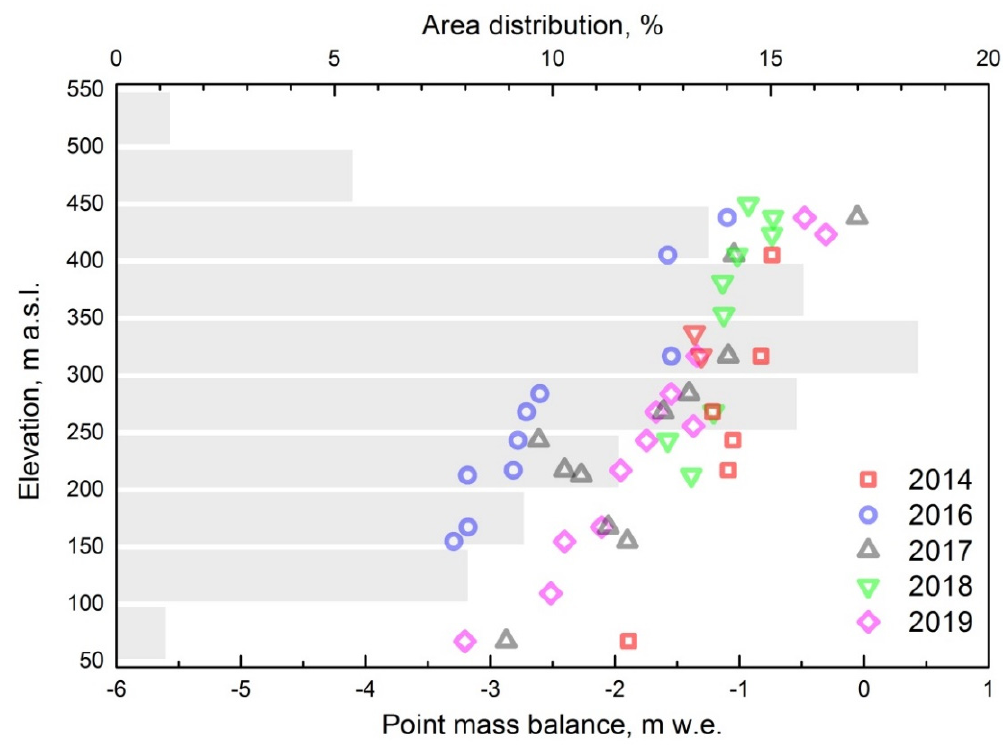
Figure 5. Single point mass balance values at the stakes location for 5 years and area distribution of Austre Grønfjordbreen in 2019.